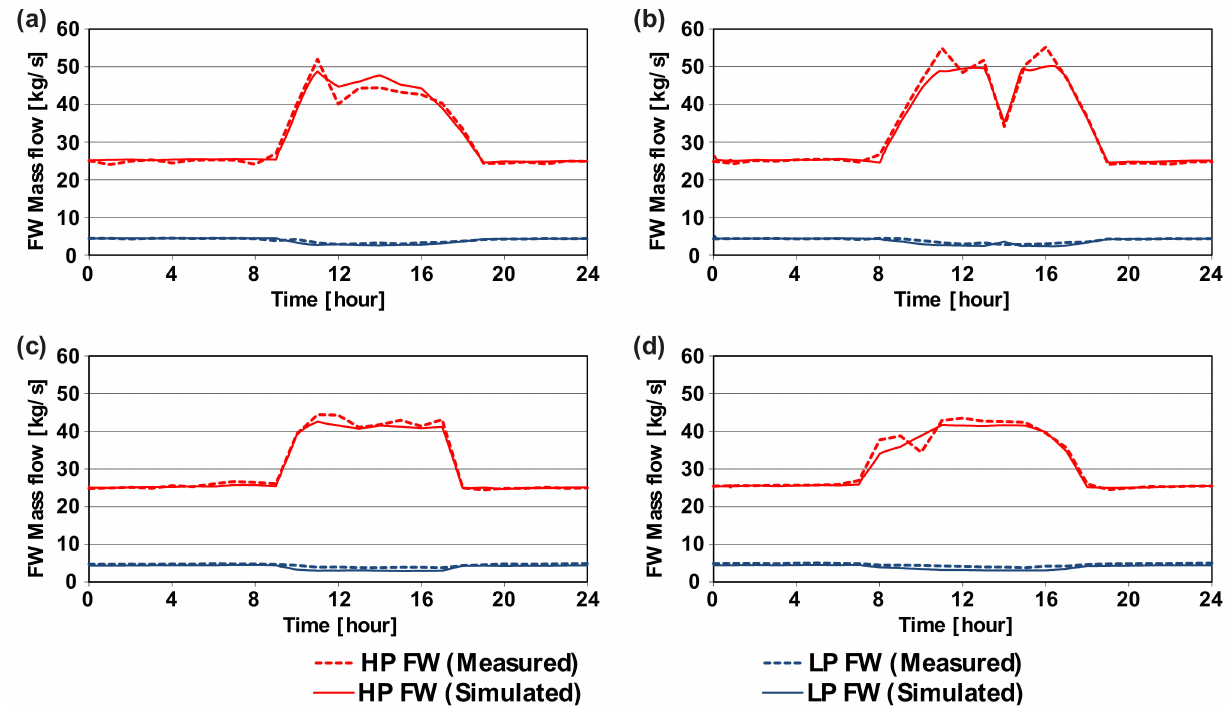
Figure 8. The feedwater (FW) mass flow rate for four days: ( a ) 20 July 2013; ( b ) 21 July 2013; ( c ) 30 August 2013 and ( d ) 4 September